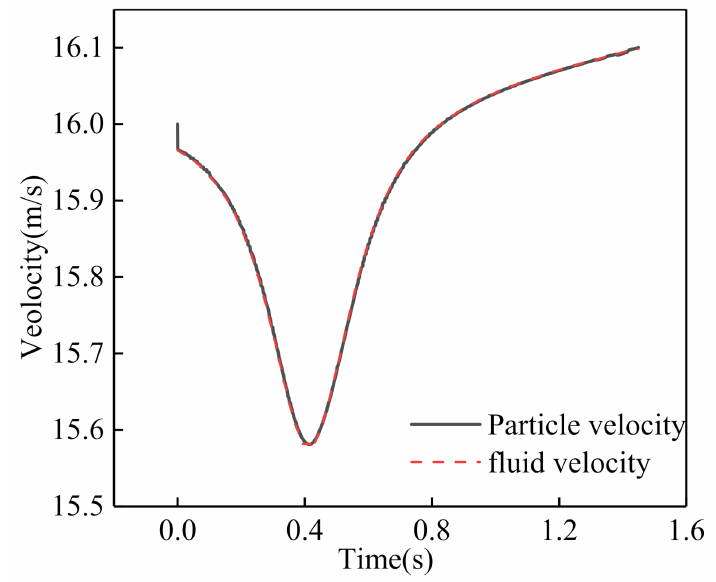
Figure 13. The particle velocity and the fluid velocity along the trajectory of Particle ID = 5 (particle diameter = 20 µ m).